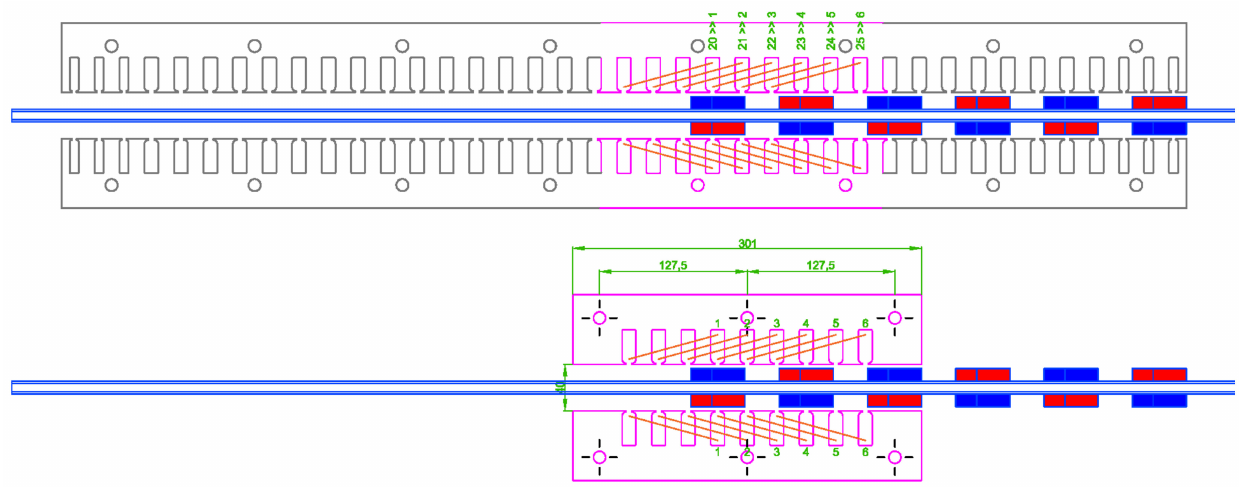
Figure 2. Comparison of the active parts of the two